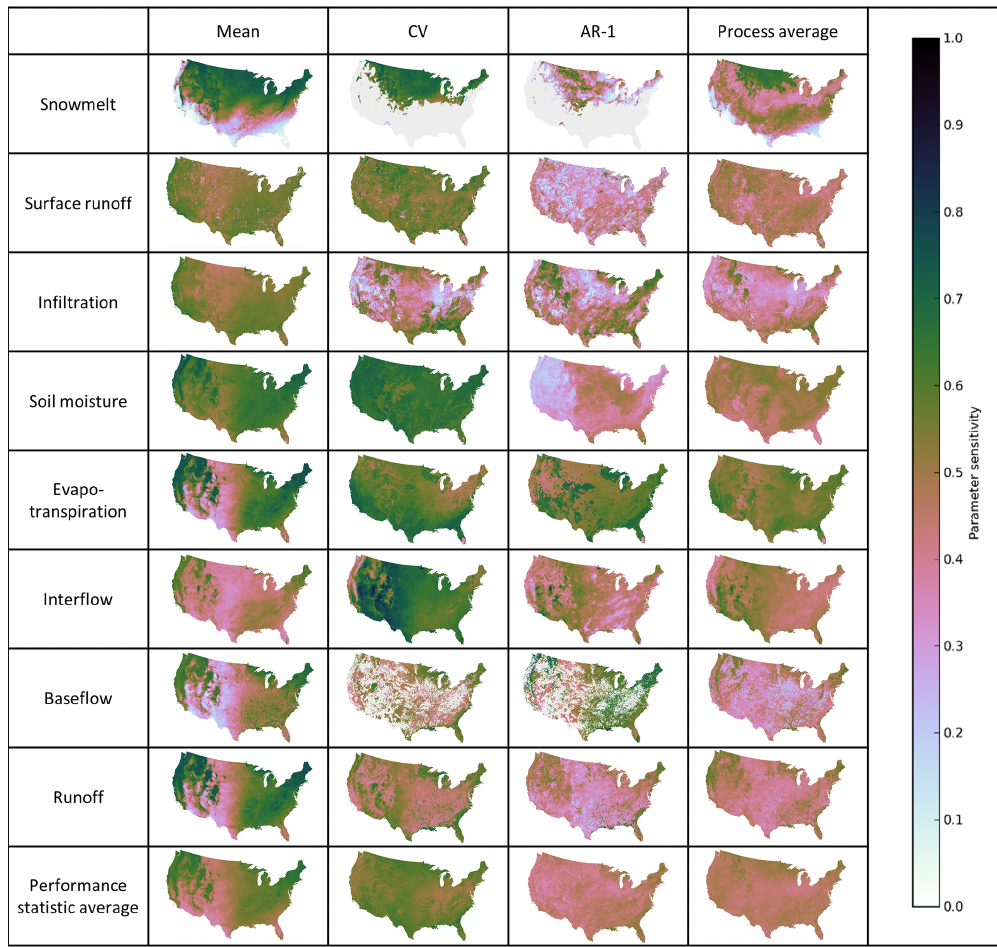
Figure 2. Maps of the conterminous US showing Precipitation–Runoff Modeling System parameter sensitivity by Hydrologic Response Unit (HRU) by process and performance statistic. The HRU parameter sensitivity is computed by summing the first-order sensitivity for all parameters. The process average maps are made by averaging the parameter sensitivity values computed for the different performance statistics. The performance statistic maps are made averaging the parameter sensitivity values computed for the different